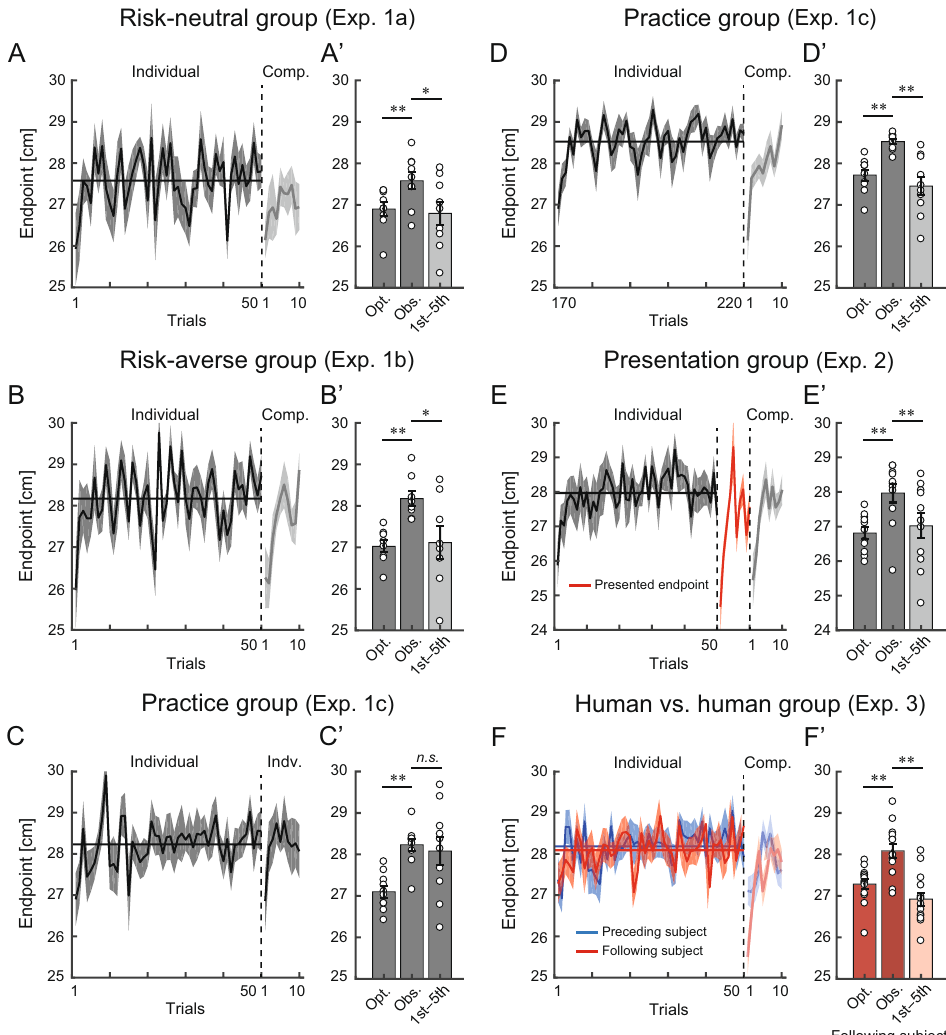
Figure 4. Reversal of strategy from risk-seeking to risk-averse. ( A–F ) Time series of the reaching endpoint in the individual task and the first block of the competitive task. Data is averaged across the subjects and the shaded area denotes the standard error of the mean. The horizontal solid line indicates the observed mean endpoint in the 50 trials of the individual task before the competitive task started ( A,B , D–F ) or when the individual task restarted ( C ). ( A’–F’ ) The bar graphs show the reaching endpoint. Data is averaged across the subjects, and the error bar denotes the standard error of the mean. Opt. indicates the optimal mean endpoint in the individual task for 50 trials, whereas Obs. indicates the observed mean endpoint in the individual task for 50 trials corresponding to the horizontal solid line in ( A–F ). Further, 1st–5th indicates the average endpoints across the first to fifth trials after the competitive task started ( A’,B’ and D’–F’ ) or when the individual task restarted ( C’ ). * represents p < 0.05, and ** represents p < 0.01 (paired t-test). Open circles denote the data of each subject. In the preceding individual task, the risk-seeking strategy was adopted, indicated by the deviation from the optimal to the observed mean endpoint. However, the decrease in the endpoint was seen at the beginning of the competition ( A’ , B’ ), suggesting that the subjects switched their risk-seeking strategy to risk-averse strategy. This effect was robust even when the competitive task began after the individual task was repeatedly performed ( D’ ), when the opponents’ endpoint was presented in advance ( E’ ), and when the subjects competed against human opponents ( F’ ). When the subjects repeated the individual task, this strategy shift was not observed ( C’ ). The data in the practice group are presented twice ( C,C’,D,D’ ) because we wanted to know whether the reversal of risk-sensitivity was not derived by performing the individual task ( C,C’ ) and was still observed after a long-term practice of the individual task ( D,D’